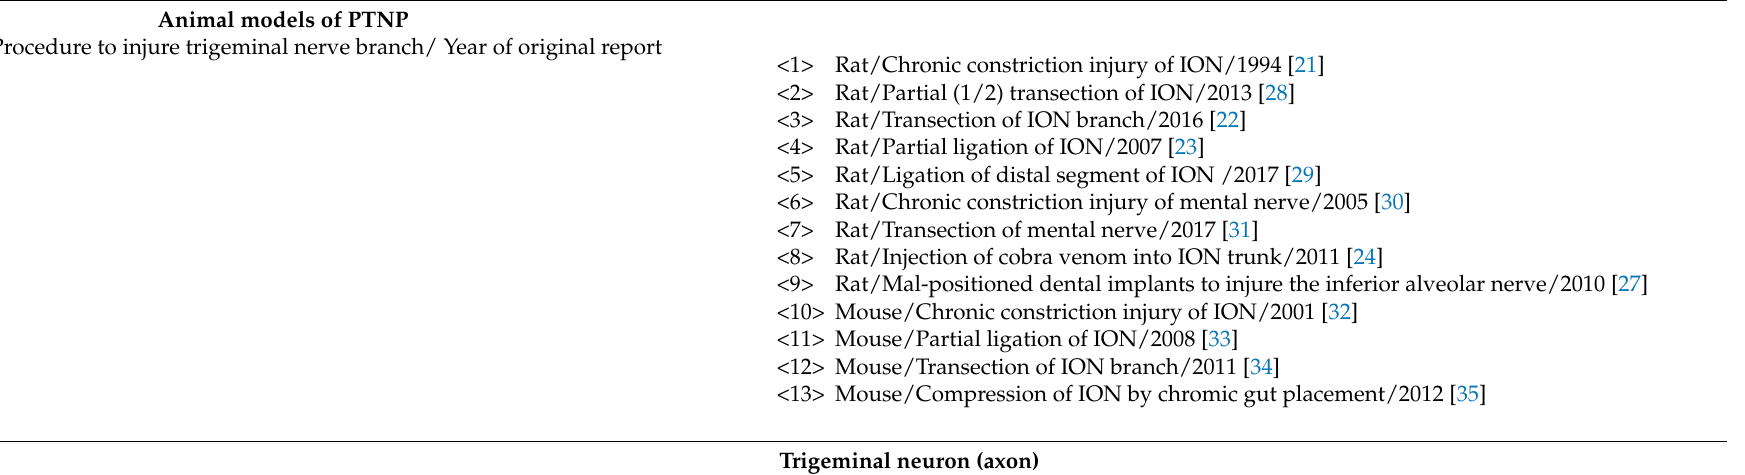
Table 1. Current findings in animal models of post-traumatic trigeminal neuropathic pain